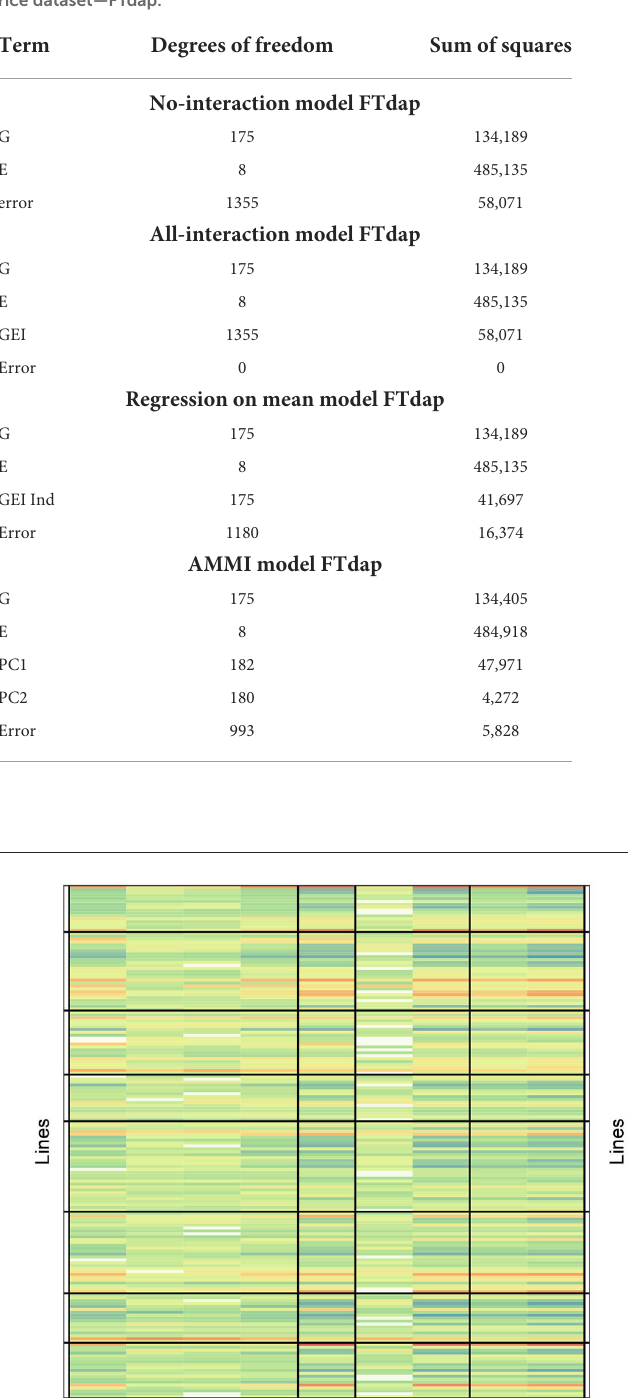
TABLE 8 Summary of degrees of freedom and sum of squares for the rice dataset—FTdap.